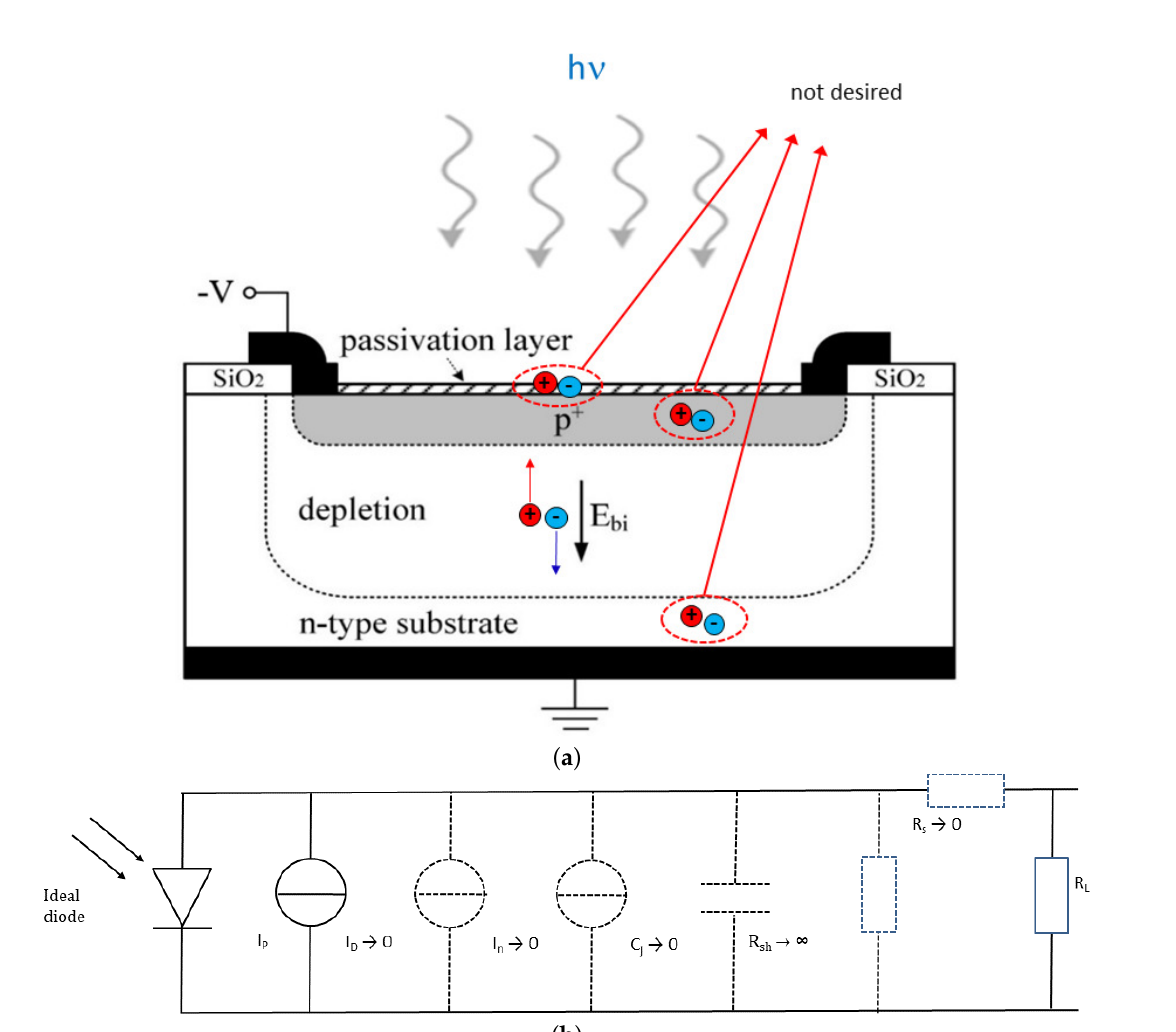
Figure 2. Vertical cross section ( a ), and electrical equivalent circuit ( b ) of a silicon p-n junction photodetector, where I D is the dark current, I p is the photogenerated current, I n is the shot noise associated with the dark current, C j is the junction capacitance, R sh is the shunt resistance, R s is the series resistance and R L is the load resistance